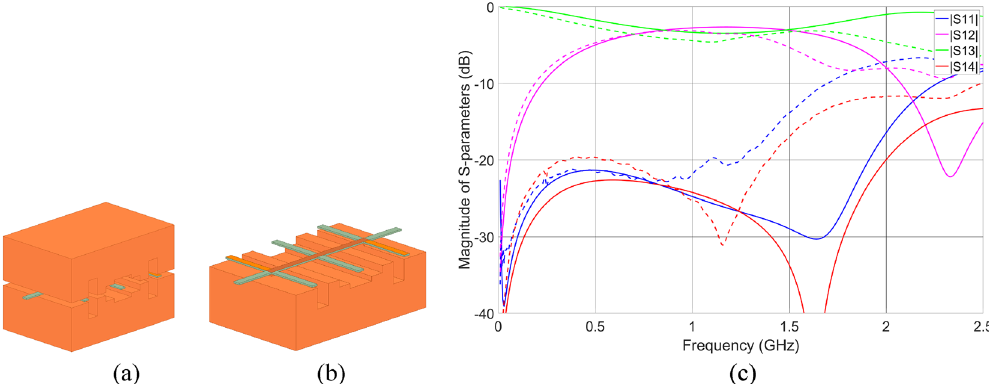
Figure 2. The 3D view on the designed coupler ( a ) and with the top enclosure removed, ( b ) orange color represents the conductive layer, whereas the green color the dielectric layer. The frequency characteristics of the designed coupler: EM simulation results—solid lines and measurement results—dashed lines ( c